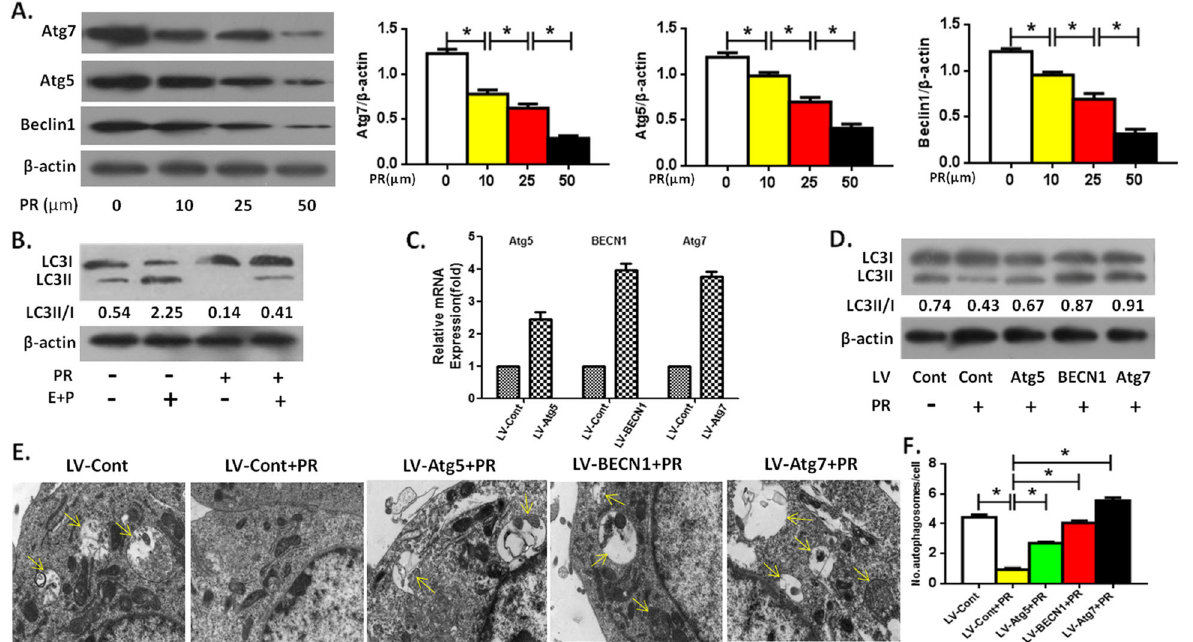
Fig. 1 Puerarin directly inhibits OCP autophagy. a The protein levels of Atg7, Beclin1 and Atg5 in the OCPs treated with different levels of Puerarin for 6 h without RANKL were measured by Western Blotting. Compared between Group 0 μ M and Group 10 μ M, Group 10 μ M and Group 25 μ M, Group 25 μ M and Group 50 μ M, respectively, * P < 0.05. b The ratio of LC3II/I in the OCPs treated with Puerarin (50 μ M) in the presence or absence of E64d + PEPS A for 8 h without RANKL. c mRNA expression of Atg5, BECN1 or Atg7 in the treated OCPs after infection with lentivirus encoding Atg5, BECN1 or Atg7 (LV- Atg5, LV-BECN1 or LV-Atg5) and the corresponding control vector (LV-Cont). d Viruses-transduced OCPs were treated with Puerarin (50 μ M) for 6 h without RANKL, and LC3II/I was detected by Western Blotting. e The autophagosomes (yellow arrows) in the viruses-transduced OCPs treated with Puerarin (50 μ M) for 24 h without RANKL were observed using TEM. Scale bar, 1 μ m. f Statistical diagrams showed the quantitative results of autophagosomes from E (45 cells from three independent assays). Data are presented as mean ± SEM from three independent experiments. Compared between Group LV-Cont and Group LV-Cont+PR, Group LV-Cont+PR and Groups LV-Atg5/BECN1/ Atg7 + PR, respectively, * P < 0.05. PR, Puerarin; Cont, control groups; E, E64D; P, PEPS